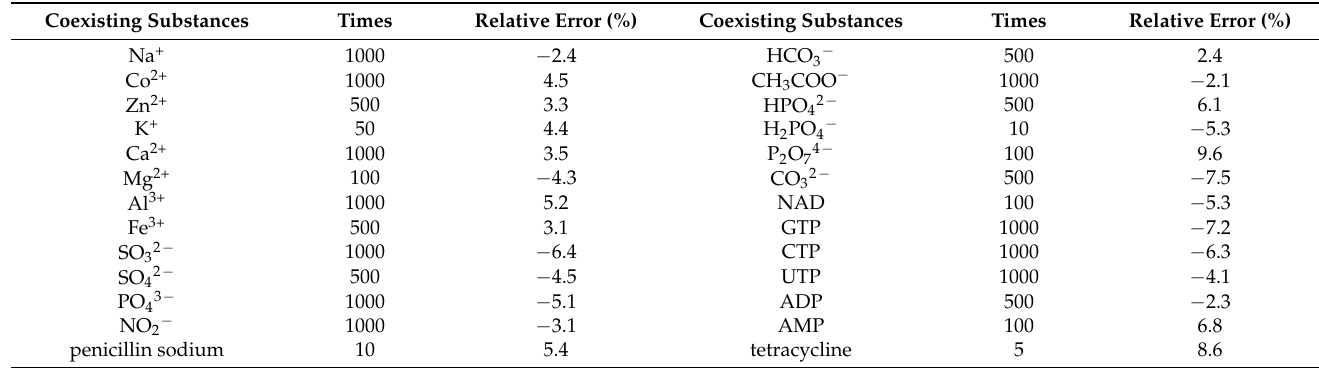
Table A3. Influence of coexistent substances (RRS).